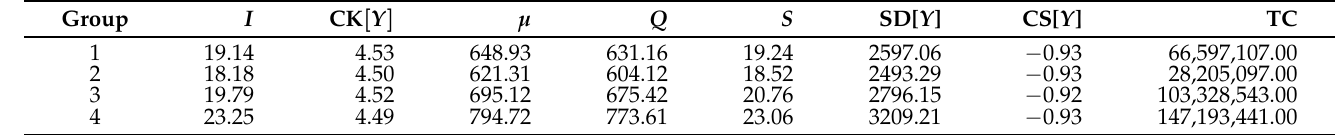
Figure 2. Visualization of the cluster analysis of the variables in the simulations through circular dendrogram ( left ) and Sankey dendrogram ( right ), with the thickness of the band proportionally representing the size of each cluster in each split procedure. Table 9. Mean of the groups of variables for the different scenarios of the simulation study. Group